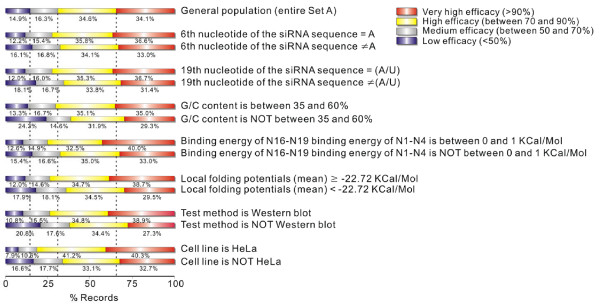
Survey of features associated with the achievement of higher efficacies. The efficacy of a siRNA experiment is rated on a four-level scale. In Set A, the percentages of records achieving these ratings are 34.1%, 34.6%, 16.3% and 14.9%, respectively. The distribution of the efficacy ratings across the four levels changes when certain feature is present in the siRNA experiments. For 14 selected features (they constitute 7 pairs of "complementary features"), the efficacy rating distributions of the subpopulations of siRNA experiments carrying these features are presented. Dotted vertical lines extend from the distribution of the general population.